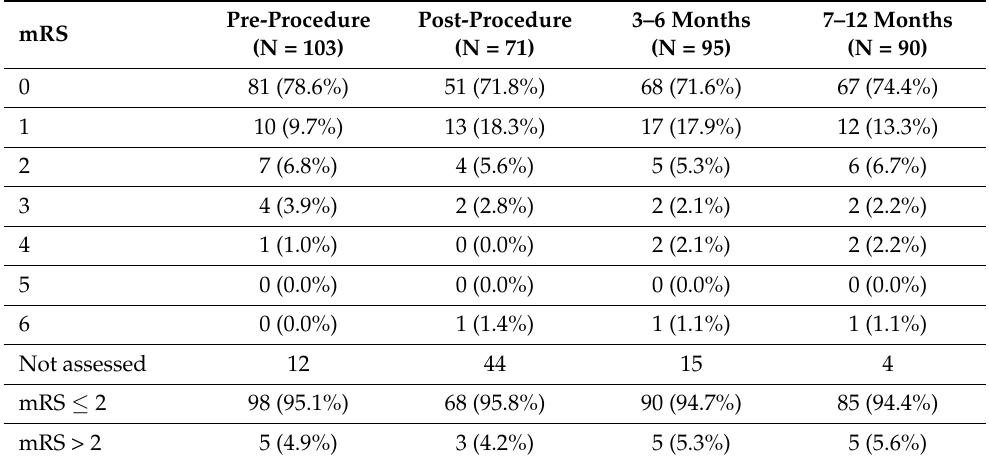
Table 5. Modified ranking score (mRS) at pre-procedure, post-procedure, and at 3–6- and 7–12-month follow-ups (ITT